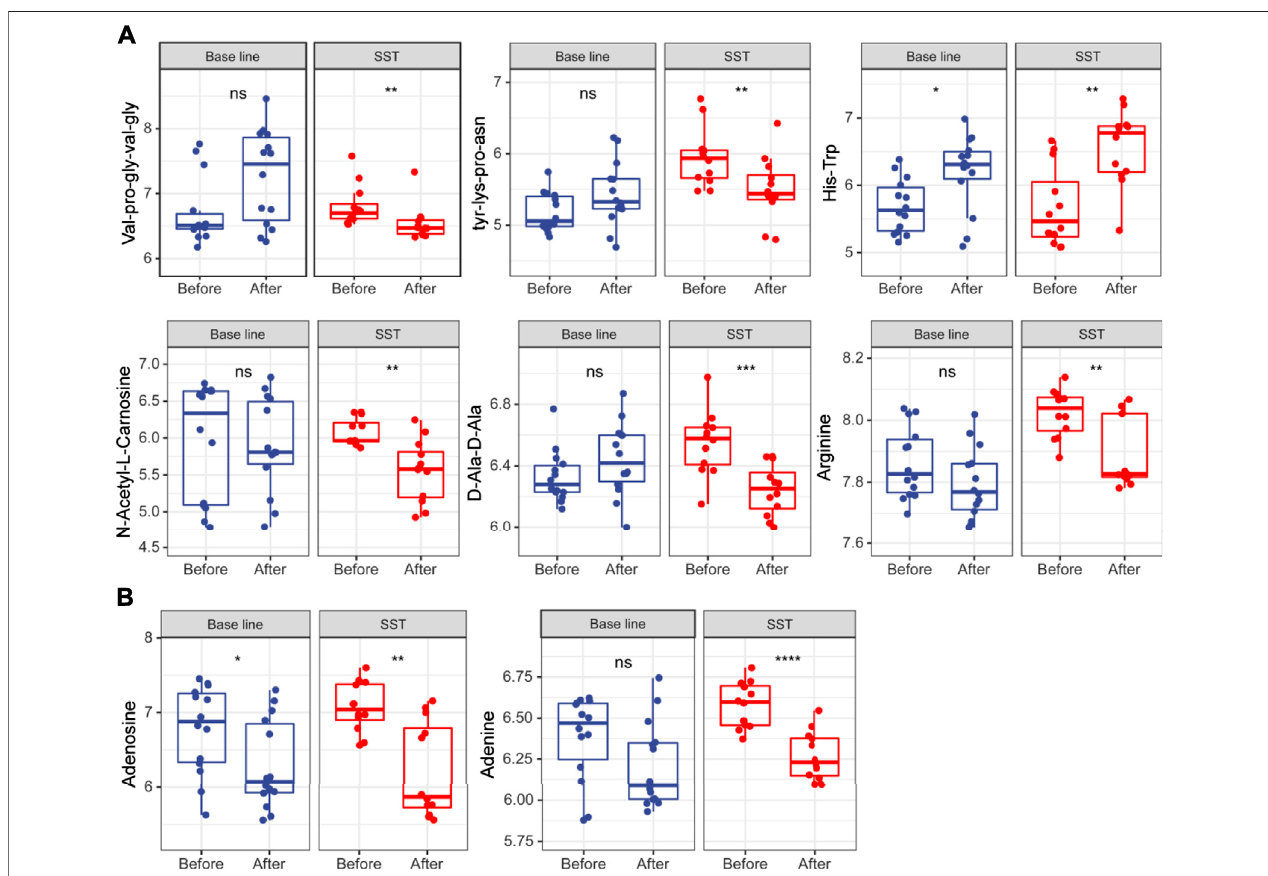
FIGURE 5 | Levels of amino acid (A) and nucleotide (B) metabolism related metabolites in serums of breast cancer patients receiving base-line chemotherapy or adjuvant SST treatment; ns, not signi fi cant; * p < 0.05, ** p < 0.01, *** p < 0.001, and **** p < 0.0001 by student ’ s t test.